Question: Compose a caption that would accompany this figure in a paper.
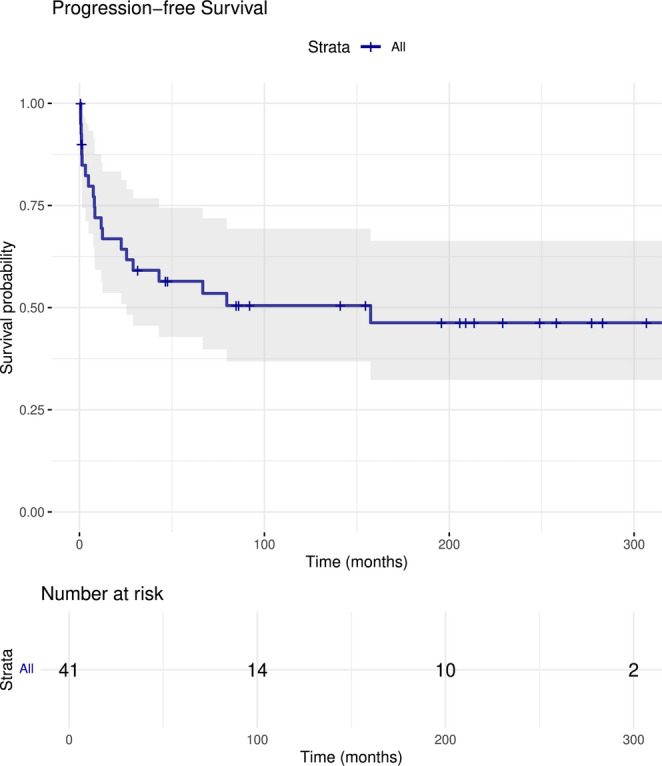
Answer: Kaplan–Meier overall study population (PFS)